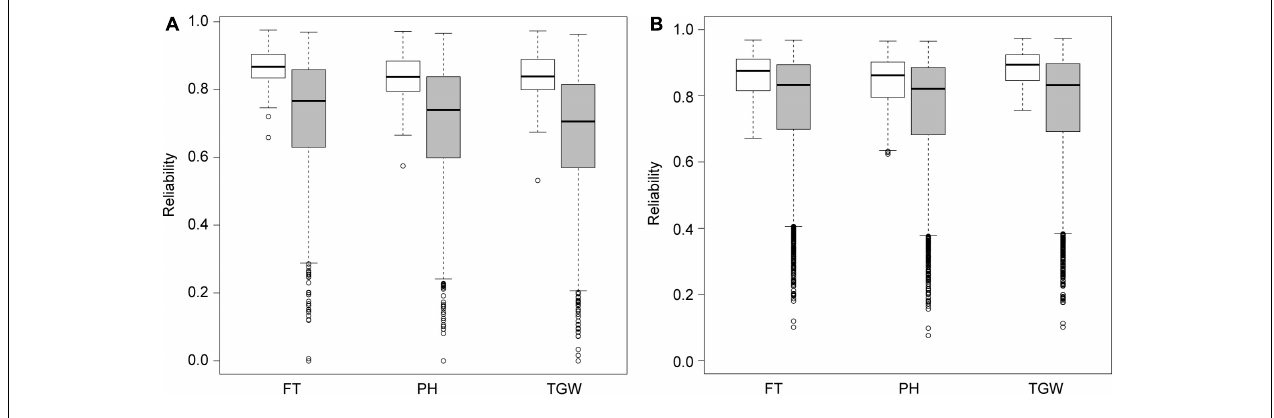
FIGURE 3 | The distribution of reliabilities for the predicted genetic values of (A) winter and (B) spring barley accessions. Reliabilities for the phenotyped and non-phenotyped accessions were separately presented in white and gray boxes. FT, flowering time; PH, plant height; TGW, thousand grain weight. TABLE 3 | Genome-wide prediction abilities of flowering time (FT), plant height (PH), and thousand grain weight (TGW) within and across row type subpopulations for the spring barley accessions. Trait Training set Test set 2-Rowed 6-Rowed Deficiens Intermedium